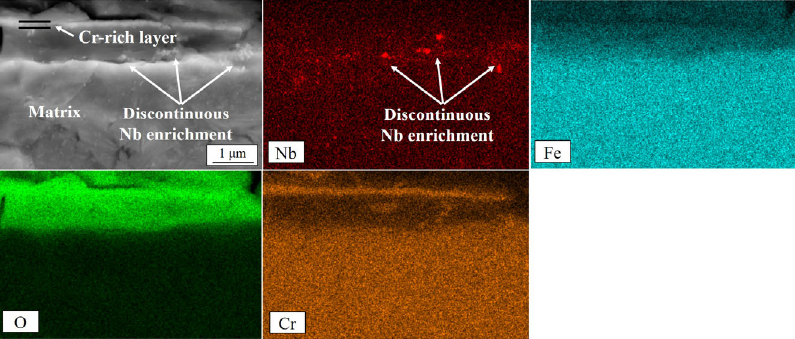
Figure 8. Cross-sectional SEM with the corresponding EDS mapping images of sample S2 after ex-